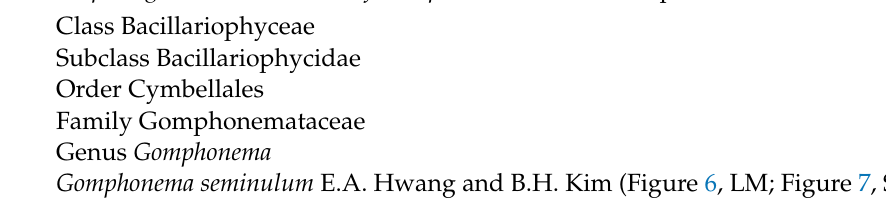
Figure 5. rbcL maximum likelihood phylogenetic tree of Hannaea librata sp. nov. and other species. The tree with the highest log likelihood ( − 1639.58) is shown. The percentages of trees in which the associated taxa clustered together are shown next to the branches. The analysis involved 22 nucleotide sequences and 596 positions in the final data set. Cyclotella meneghiniana was used as the outgroup. 3.3. Morphological Characteristics of Gomphonema Seminulum sp. nov.